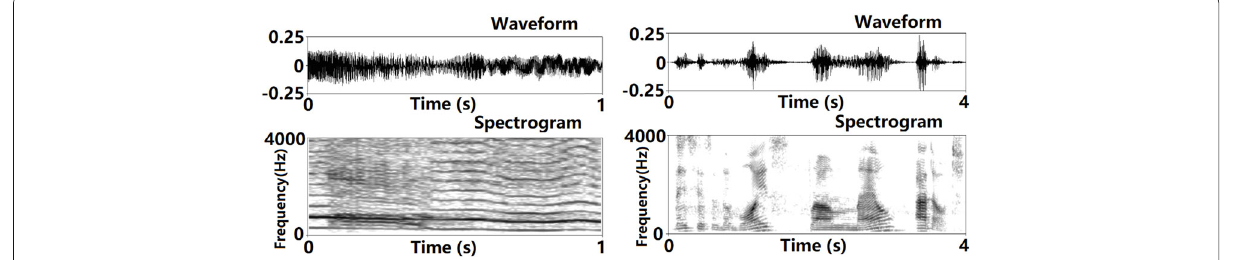
Fig. 2 Adult speech vs. infant cry signal in time and frequency domain